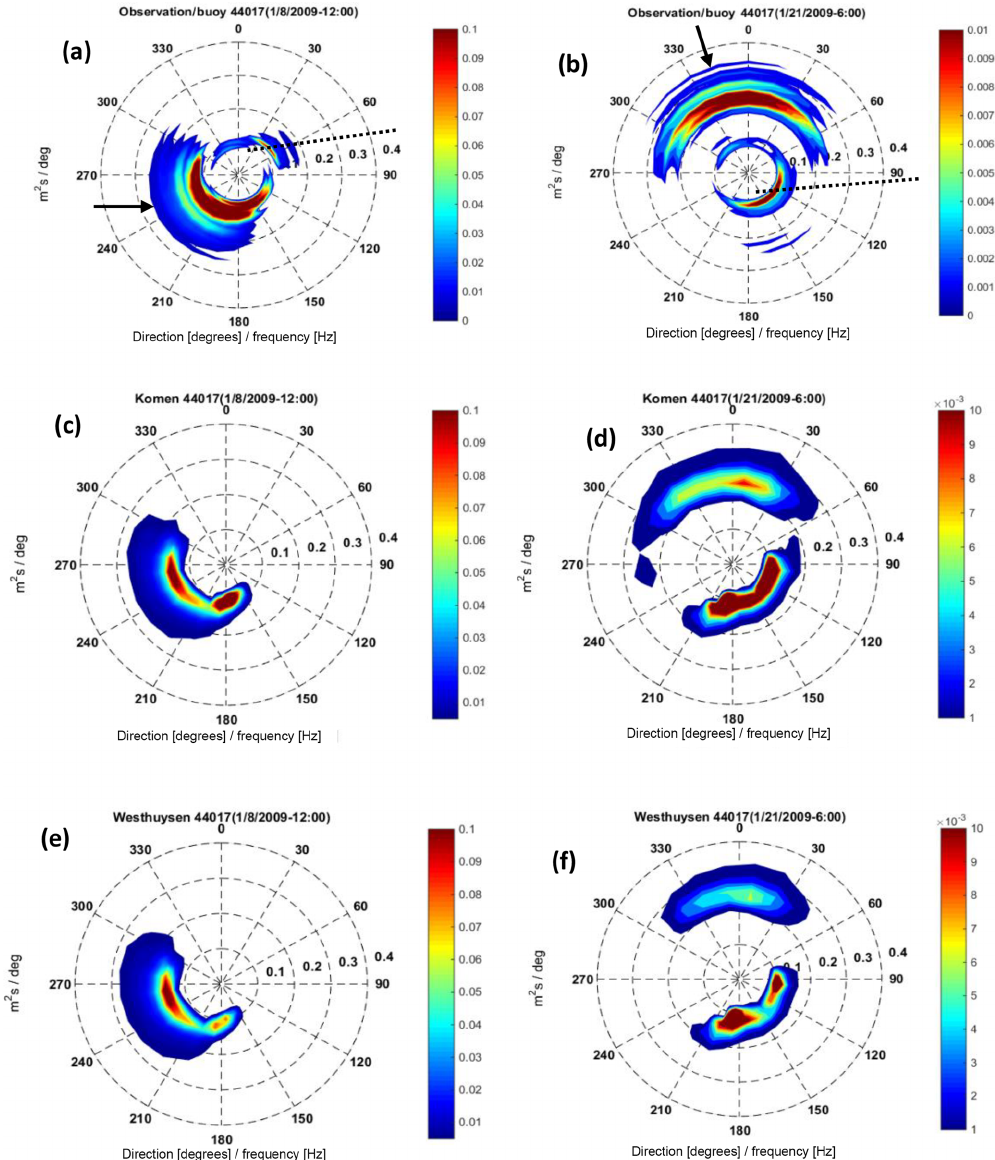
Figure 15. (a, c, e) Frequency–directional spectra from observation, Komen simulation, and Westhuysen simulation, respectively, at 44017 for time t1 and (b, d, f) the same spectra at t2. The solid arrows show the direction of observed CFSR wind at the buoy. The direction of the shoreline in the vicinity of the buoy is shown with dotted